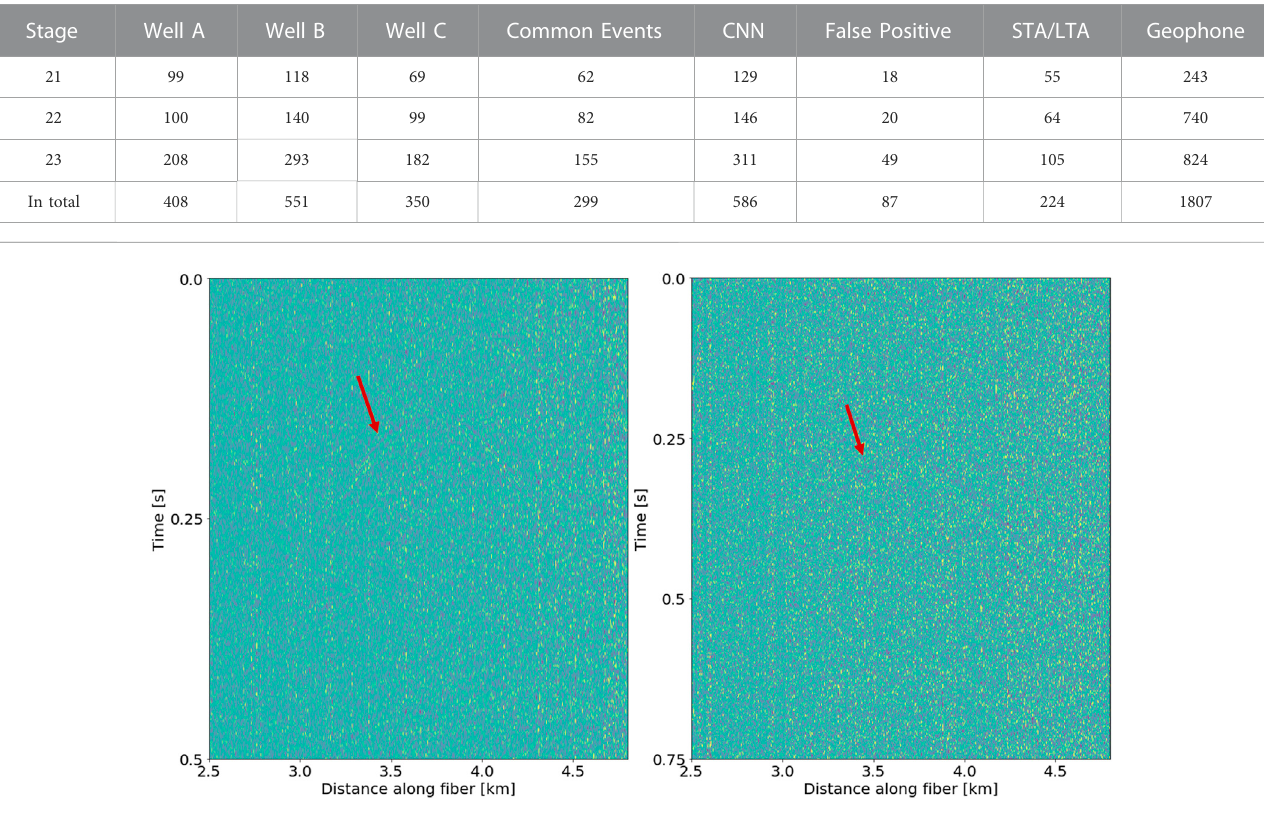
TABLE 1 Case study 1: Comparison of DAS CNN, STA/LTA, and geophone performance for event detection .